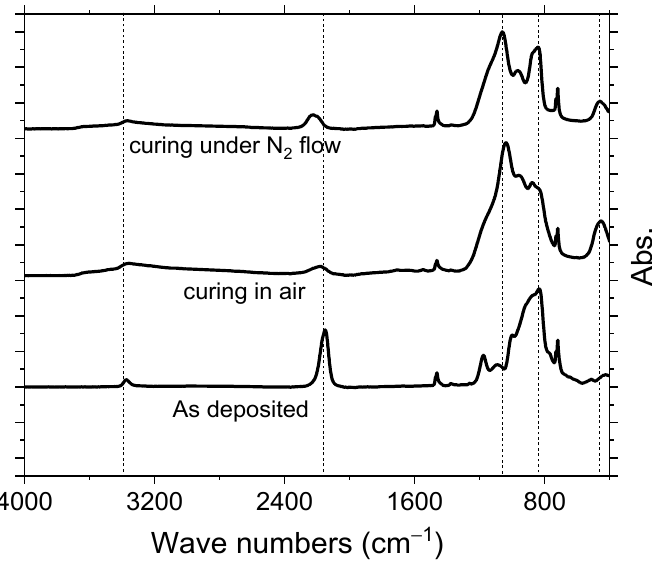
Figure 3. FTIR spectra of PHPS cured under different curing environments. PHPS films were irradiated with deep UV, from a distance of 100 mm for 60 min with a constant but milder flow of nitrogen gas and air between sample and deep UV source.